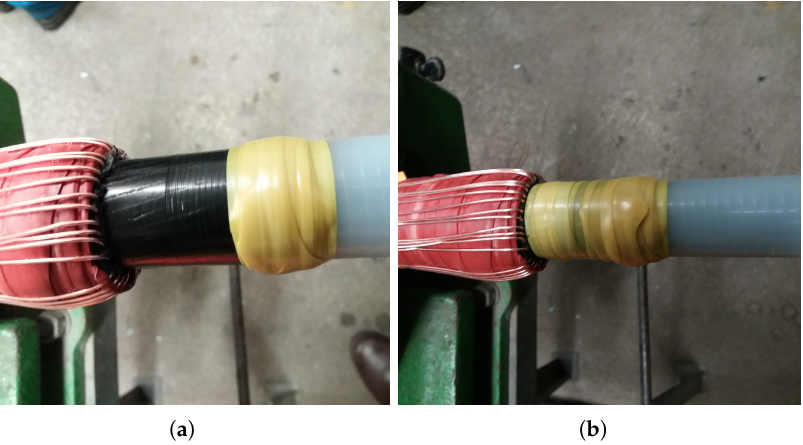
Figure 6. Stage of installation of the SN cable head type Energy Partners 24-EPOT-1/70-240/(U): ( a ) installation of the EP-STRESS tape on the cable surface according to the assembly instructions, ( b ) additional fastening of the tape on a larger area of the cable